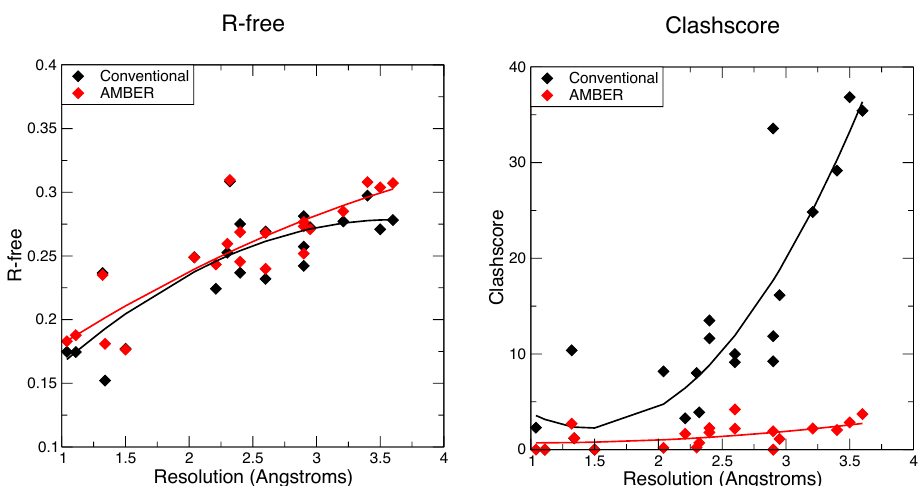
Figure 1. Values for R-free and Molprobity clashscore for the AMBER-restrained and conventionally restrained refinements.